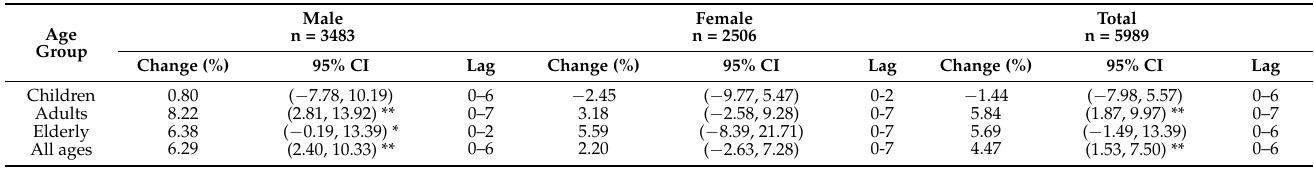
Table 2. Percentage change (95% confidence interval) in the daily number of asthma patients treated with nebulized medication in relation to a 1 ◦ C decrease in mean temperature according to sex and age group.